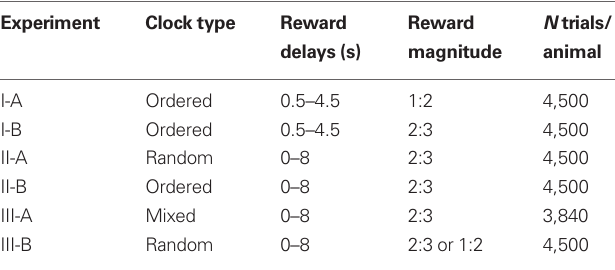
Table 1 | Summary of conditions tested in each